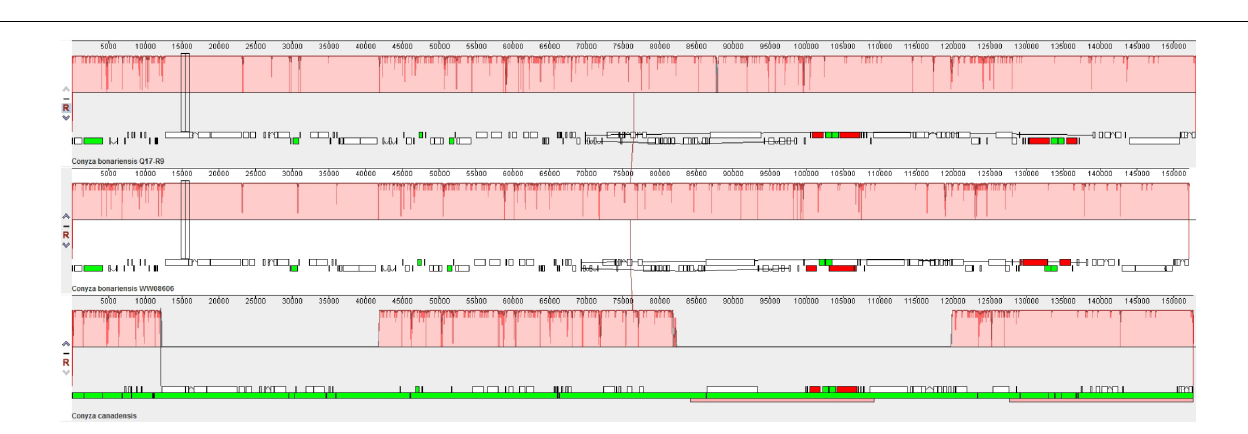
Frontiers in Genetics |